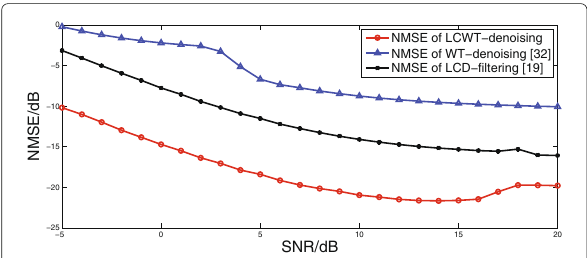
Fig. 12 Performance of the LCWT-based denoising, WT-based denoising [32], and LCD-filtering [19]. WT-based denoising’s decomposition level is 2. The LCD filter is a 128 order low-pass FIR filter with 8 Hz pass frequency and 10 Hz stop